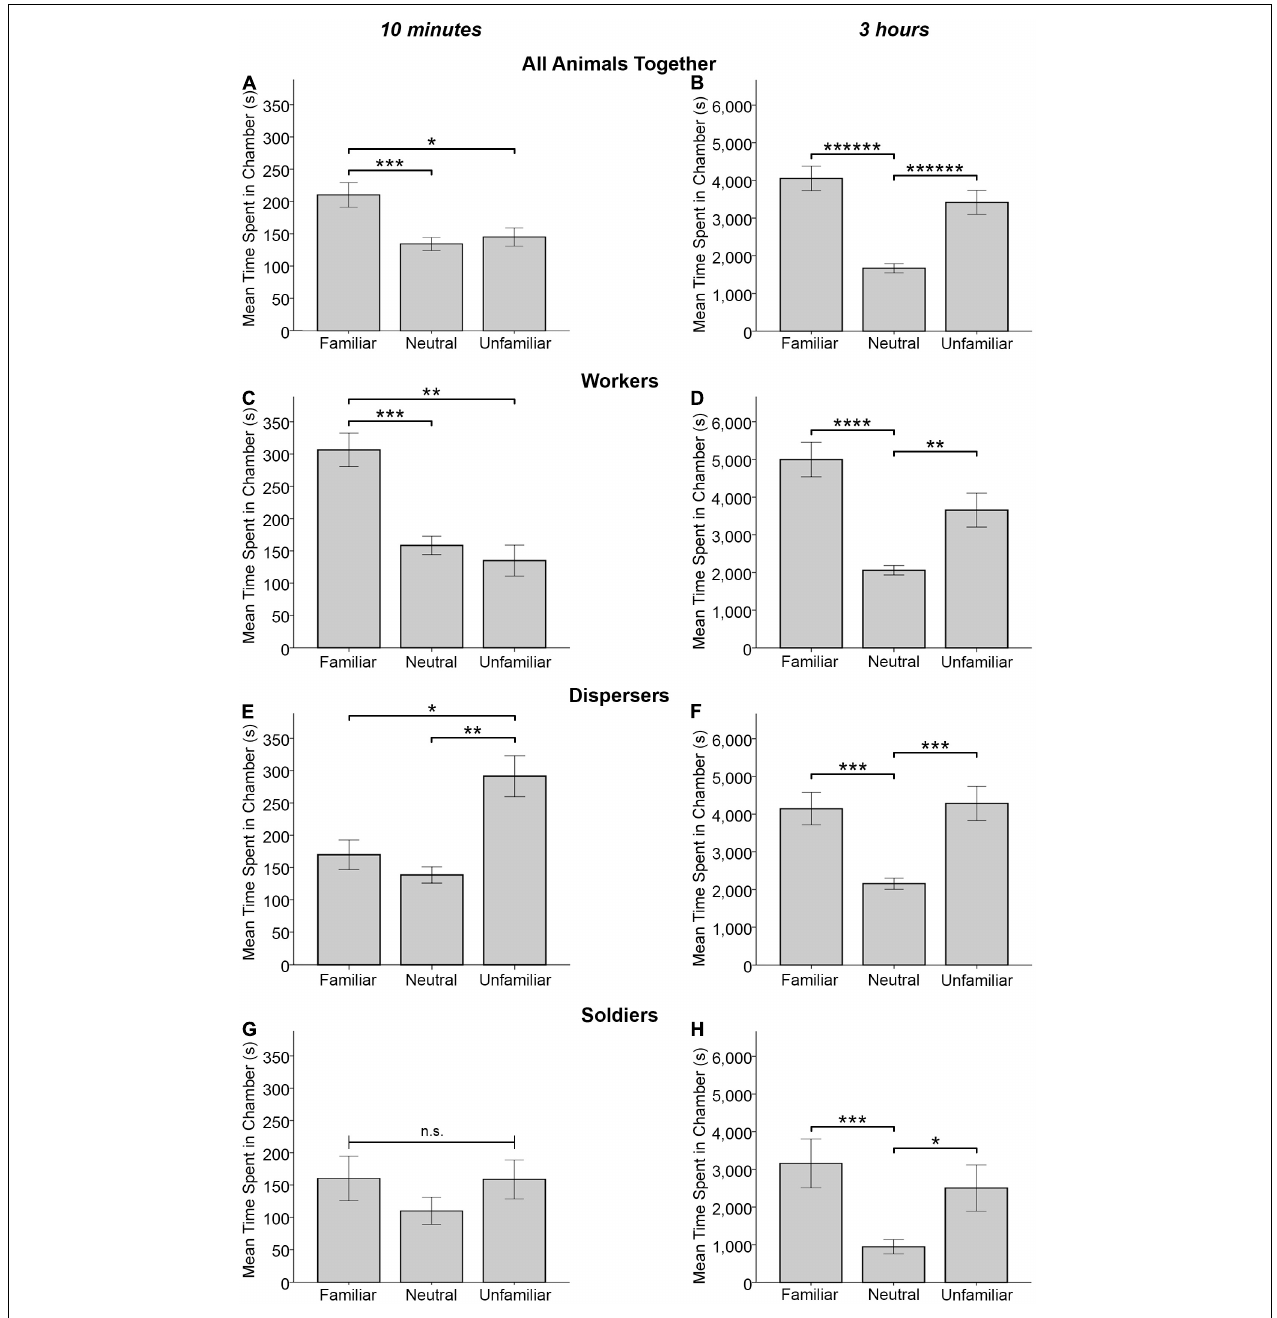
FIGURE 4 | Mean time spent in a chamber ( ± SEM) with either a familiar animal, unfamiliar animal, or alone in the neutral chamber by all experimental animals (A,B) , workers only ( n = 17; C,D ), dispersers only ( n = 16; E,F ), and soldiers only ( n = 20; G,H ). Data are plotted for the 10 min time point (A,C,E,G) and the full 3 h test (B,D,F,H) . All animals and all three behavioral phenotypes spent significantly more time in a chamber with another animal vs. being alone in the center chamber for the full 3 h test. At the 10 min time point, dispersers spent more time in the chamber with an unfamiliar animal vs. a familiar animal (E) and workers spent more time in the chamber with a familiar animal vs. an unfamiliar animal ( C , also seen for all animals together in A ). n.s. = not significant, * p < 0.05, ** p < 0.01, *** p < 0.001, **** p < 0.0001, ****** p < 0.000001 for pairwise